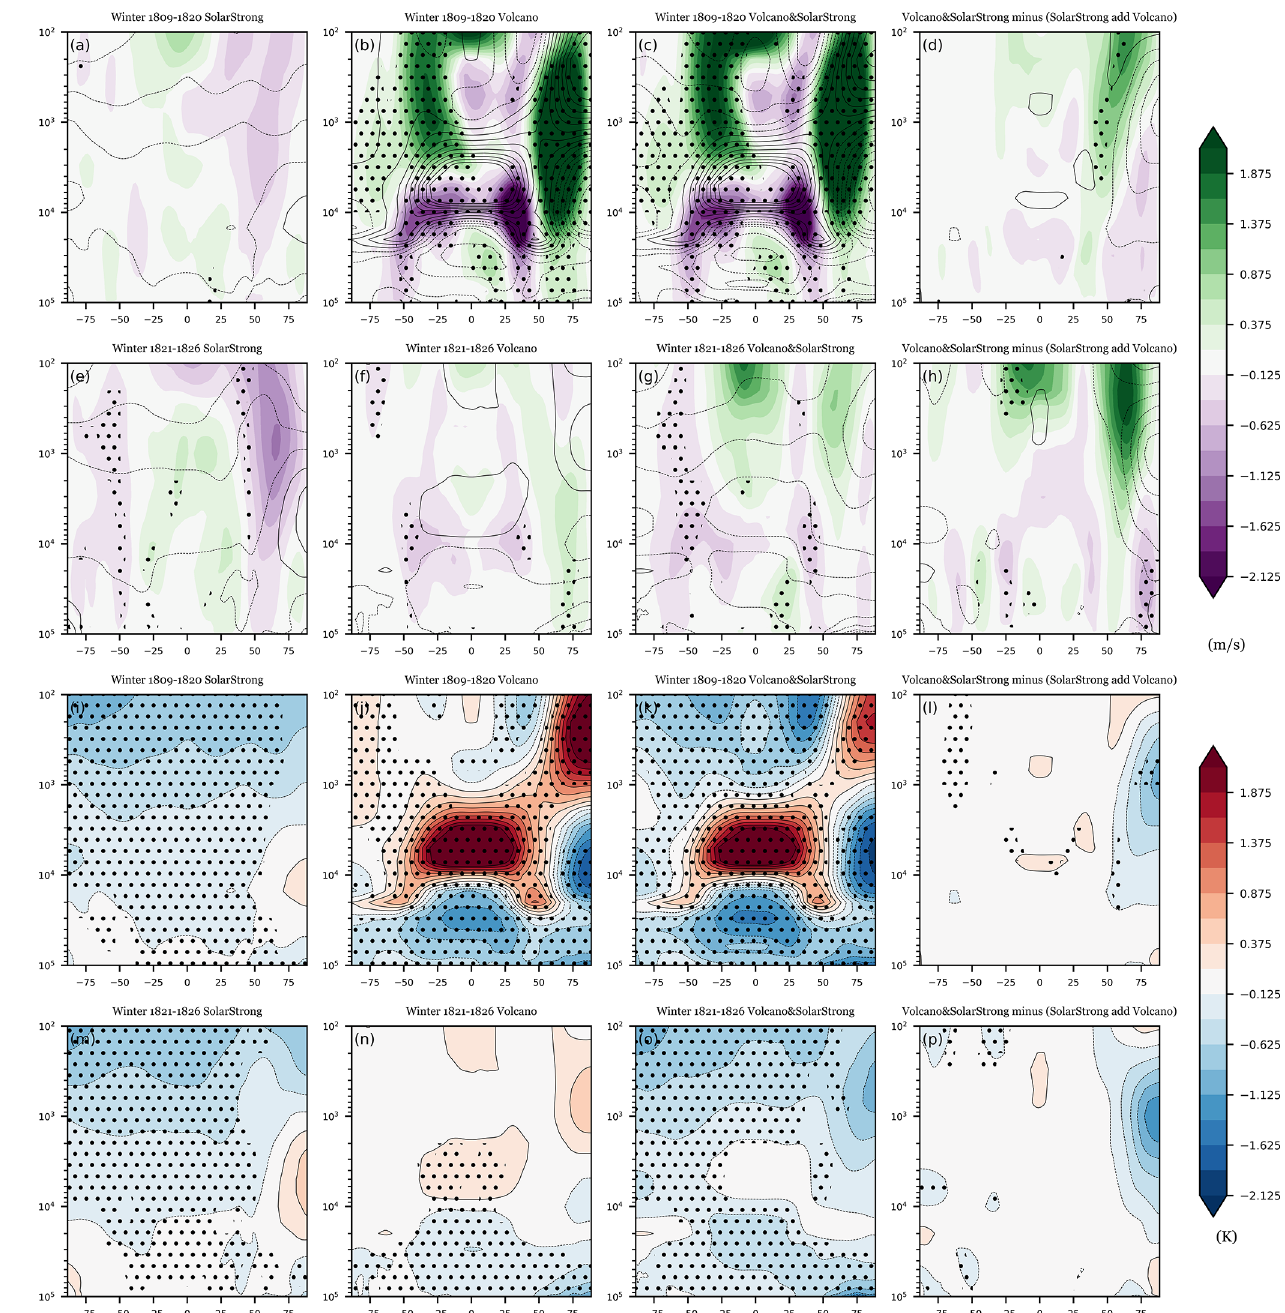
Figure 9. (a) Ensemble mean of composite zonal mean temperature (K; contour with internal 0.25K) and zonal winds (ms − 1 ; shading) anomalies over 1809–1820 winters for SolarStrong experiment. (b) Volcano, (c) Volcano&SolarStrong, and (d) Volcano&SolarStrong minus (SolarStrong plus Volcano). The black dots in (a) – (c) show the grid points with significant differences (5% level) of zonal mean zonal winds compared to the Basic experiment, while in (d) shows the significant differences between the Volcano&SolarStrong and SolarStrong plus Volcano. (e) – (h) are for 1821–1826 winters. (i) – (p) are for zonal mean temperature, and also the black dots.